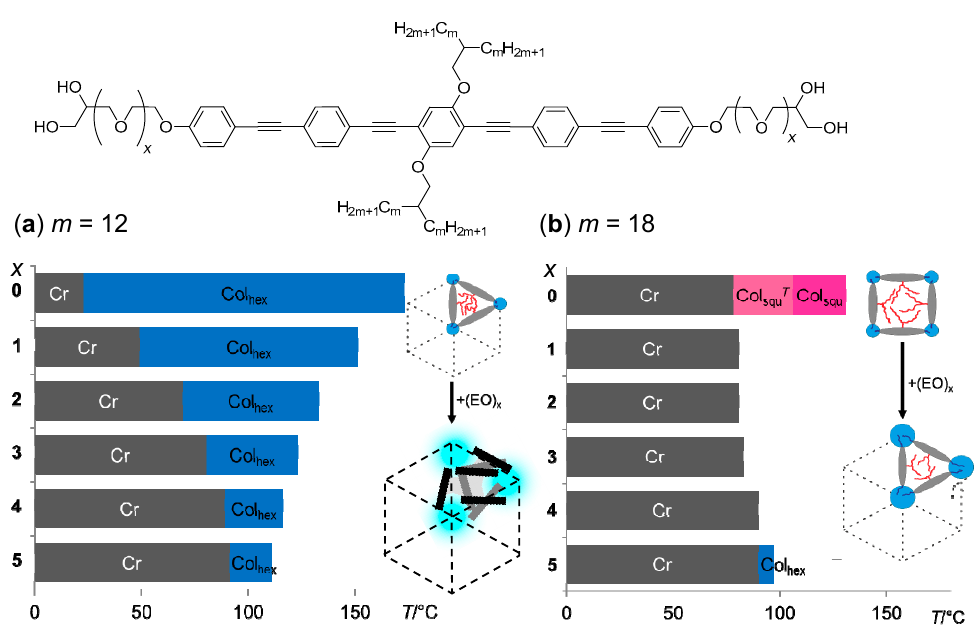
Figure 10. Bar diagrams illustrating the dependence of the LC phases and their transition temperatures (cooling with 10 K · min − 1 ) on the number of EO units ( x ) and models of the molecular organization; ( a ) for C x 12/12 ; and ( b ) for C x 18/18 .